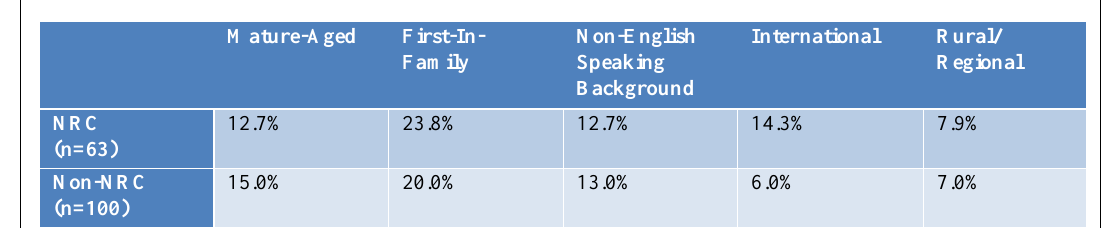
Table 2: Characteristics of survey respondents.